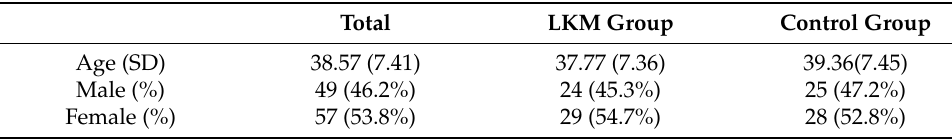
Table 1. Demographic characteristics of